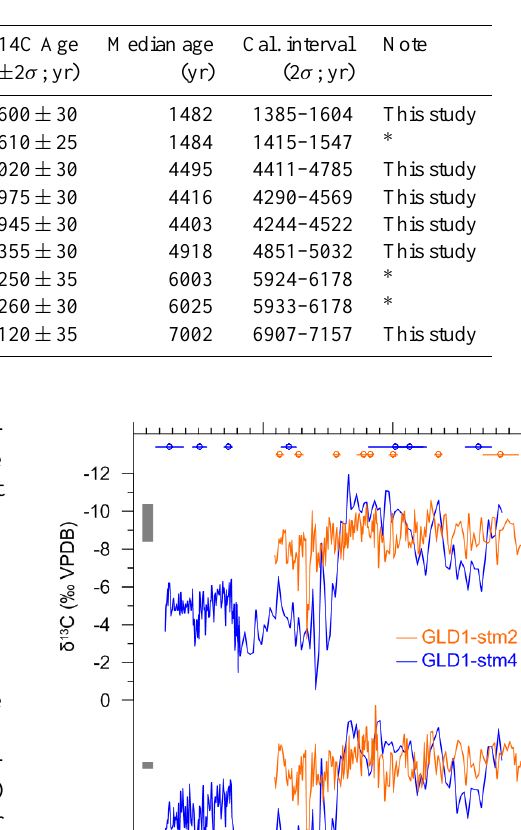
Table 2. Radiocarbon dates from AMS analyses of charcoals from excavation sector S2 inside the Gueldaman GLD1 Cave. ∗ Kherbouche et al. (2014). Ages are reported in years before 2000 AD.